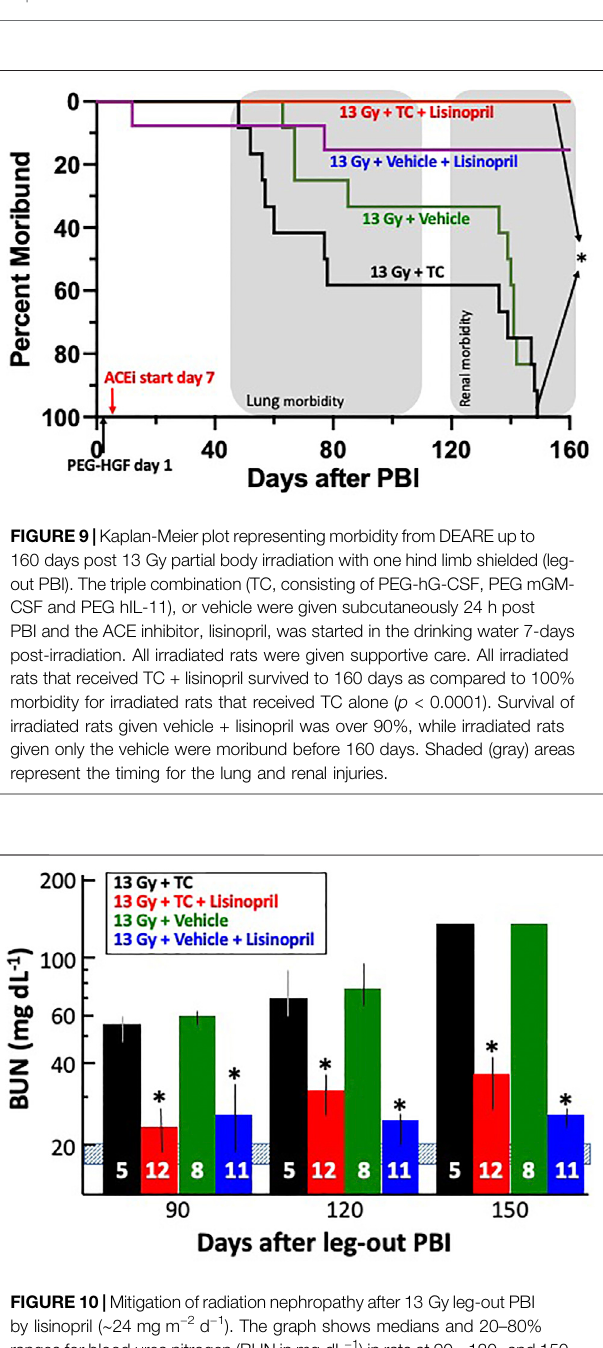
Frontiers in Pharmacology |